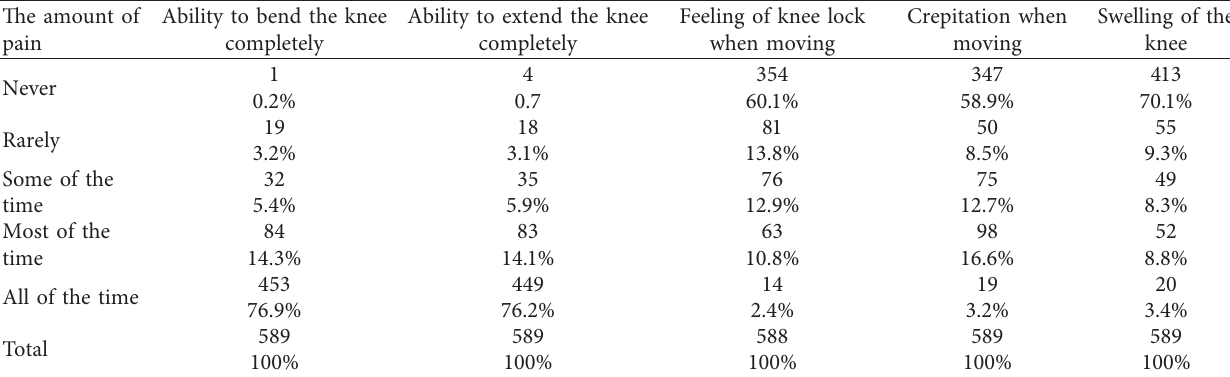
Table 2: Results of Section 1 of the knee questionnaire.